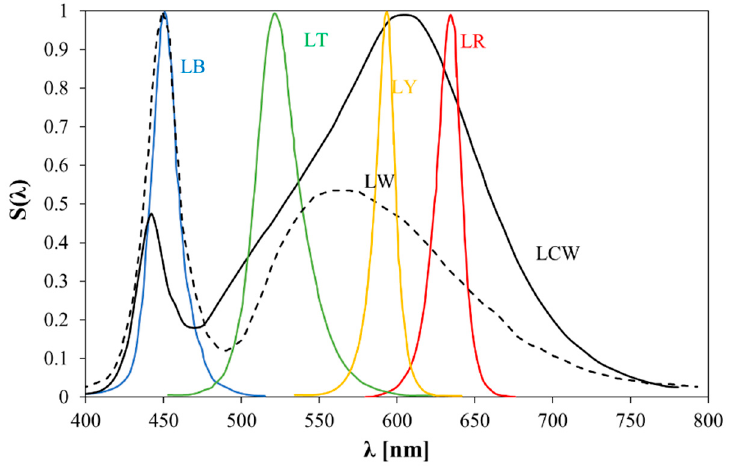
Figure 2. Relative emission spectra of the considered power LEDs.